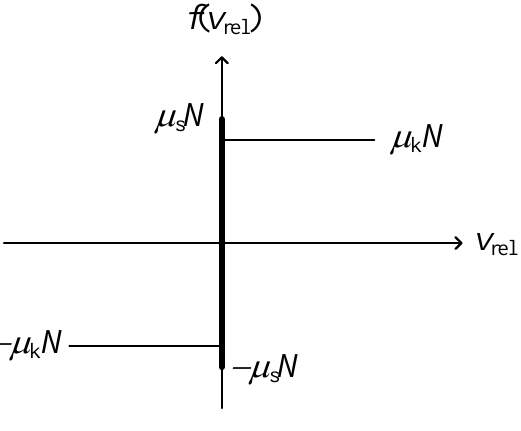
Figure 5. The classical Coulomb friction model.